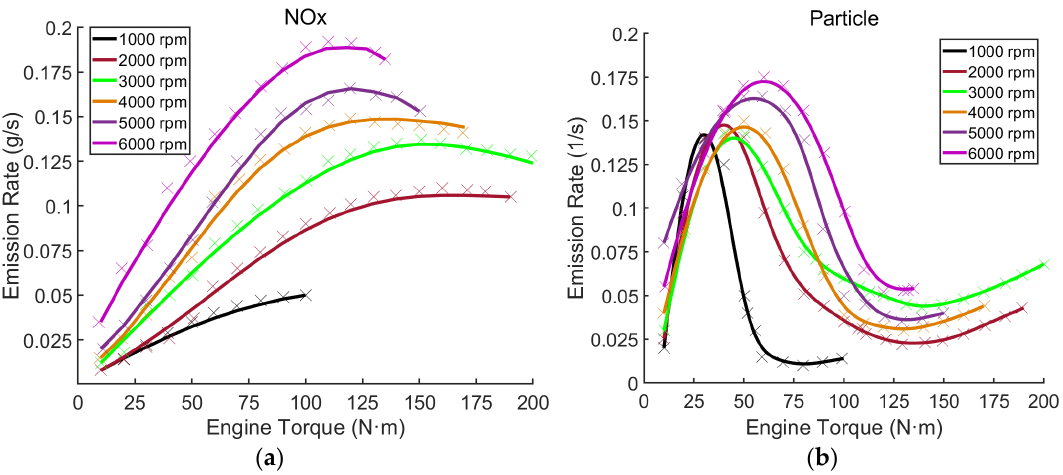
Figure 5. Quadratic polynomial fitting results of two main pollutants: ( a ) NOx and ( b ) Particle.